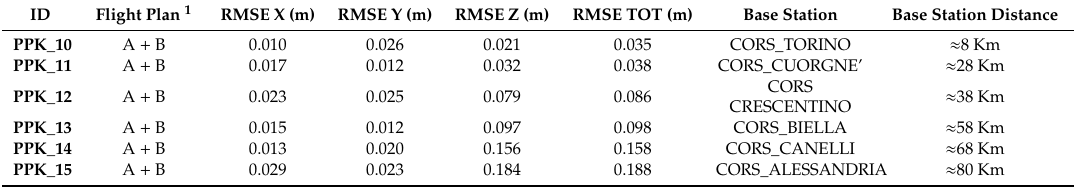
Table 12. PPK approach. RMSE on CPs for configuration from PPK_10 to PPK_15.